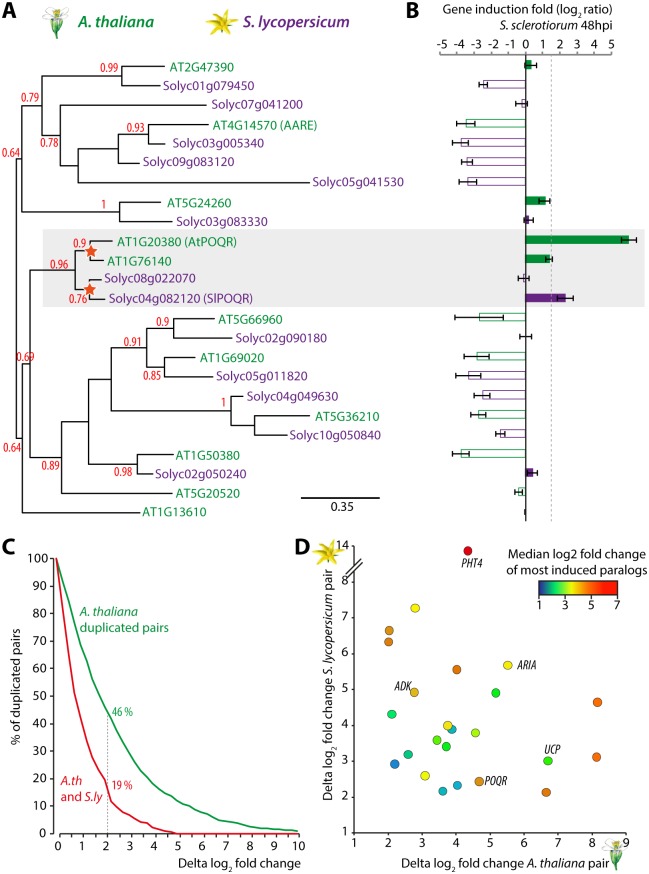
Parallel evolution of POQR gene induction upon S. sclerotiorum infection in A. thaliana and S. lycopersicum.(A) Maximum likelihood phylogenetic tree of A. thaliana (green) and S. lycopersicum (purple) prolyl-oligopeptidase (POP) family. Support corresponding to an SH-like approximate likelihood-ratio test is shown for major branches. Stars indicate gene duplication events. (B) Expression of A. thaliana and S. lycopersicum POP genes upon inoculation by S. sclerotiorum. Values show average log2 fold change (LFC) compared to mock-treated plants from three independent biological replicates, error bars show s.e.m. (C) Distribution of duplicated gene pairs according to their difference in LFC. Distribution is shown for duplicated gene pairs from A. thaliana (green, 1083 pairs) and genes duplicated both in A. thaliana and S. lycopersicum (red, 216 pairs of pairs). (D) Distribution of 21 clusters of gene duplicated both in A. thaliana and S. lycopersicum according to the delta LFC in A. thaliana gene pair (X-axis) and S. lycopersicum gene pair (Y-axis). The color code shows median of the two highest LFCs in a cluster. Labels refer to clusters commented in the text.